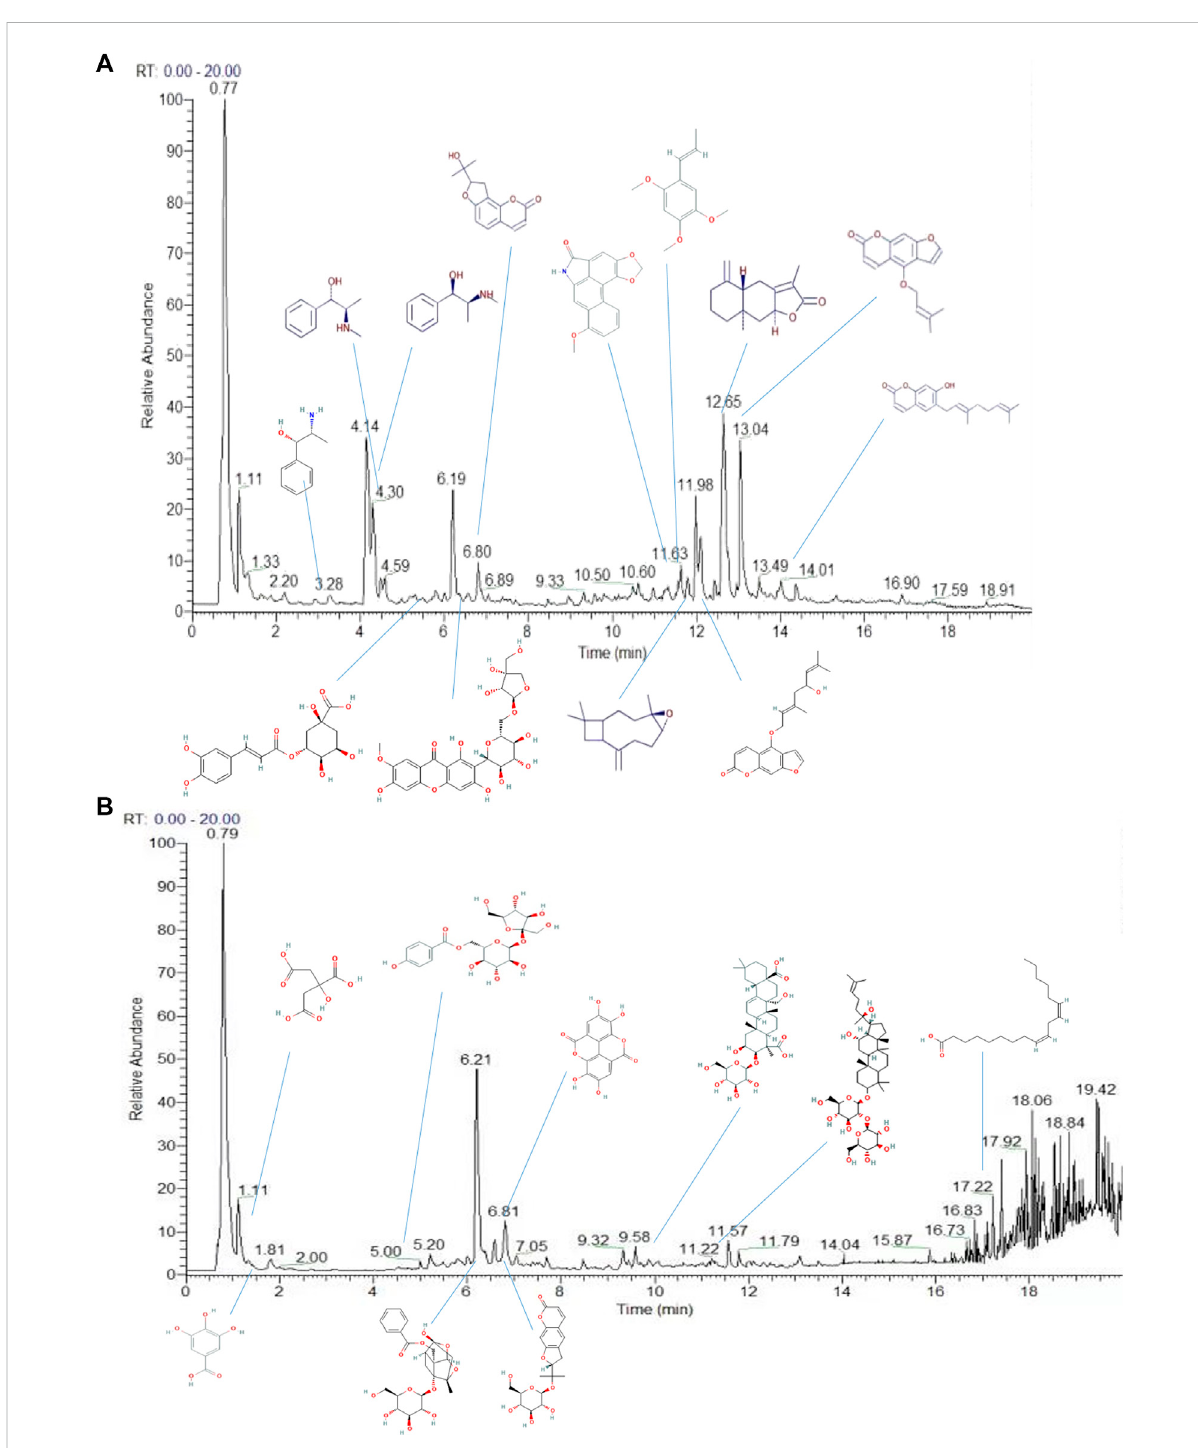
FIGURE 2 Total ion chromatograms of the chemical constituents of YZD in positive (A) and negative (B) ion modes during UHPLC-QExactiveHF